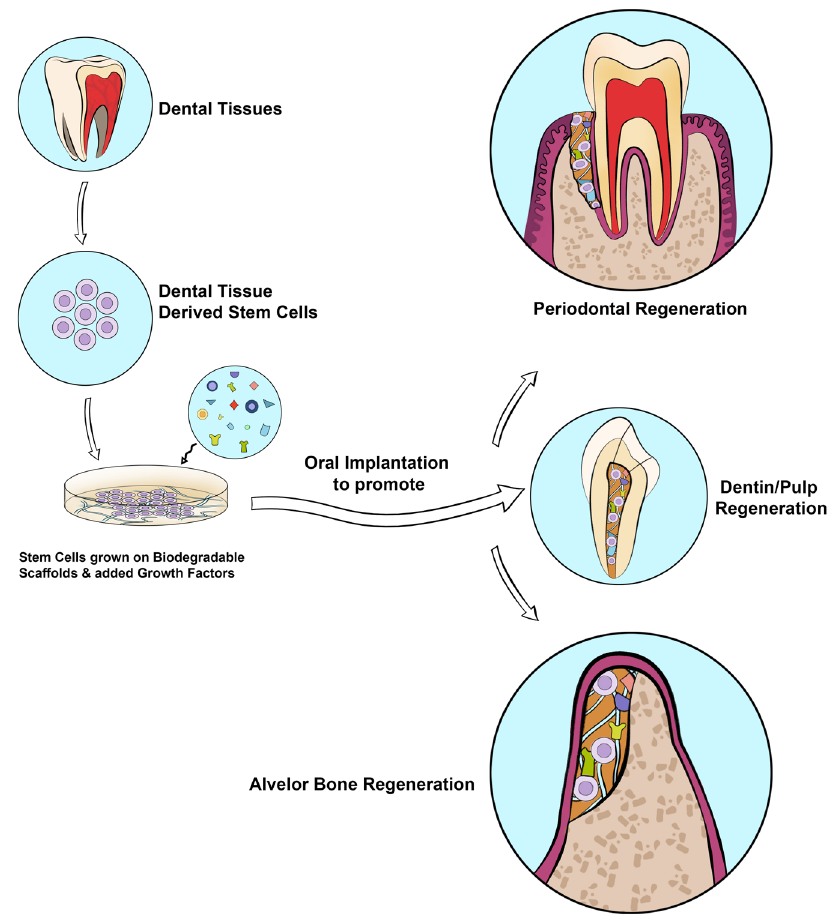
Fig. 6 Application of dental tissue-derived stem cells combined with growth factors and scaffolds in